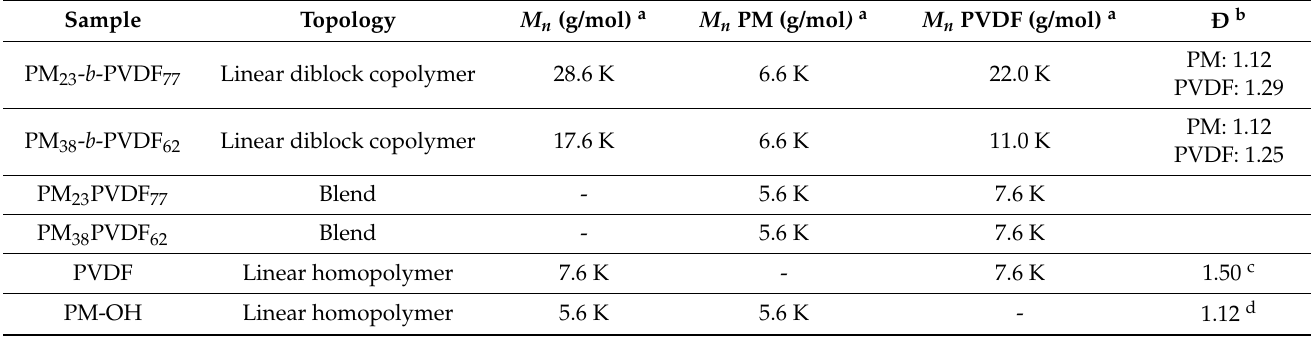
Table 1. Principal characteristics of all samples employed during this work. The subscripts indicate the wt% of each block.